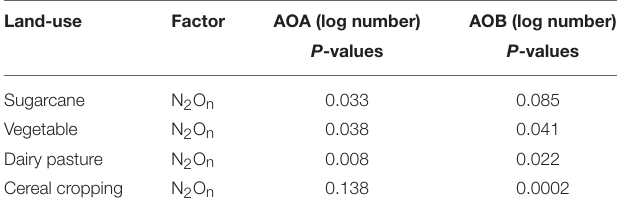
TABLE 3 | Spearman correlations between N 2 O a n and the abundances of AOA and AOB. Land-use